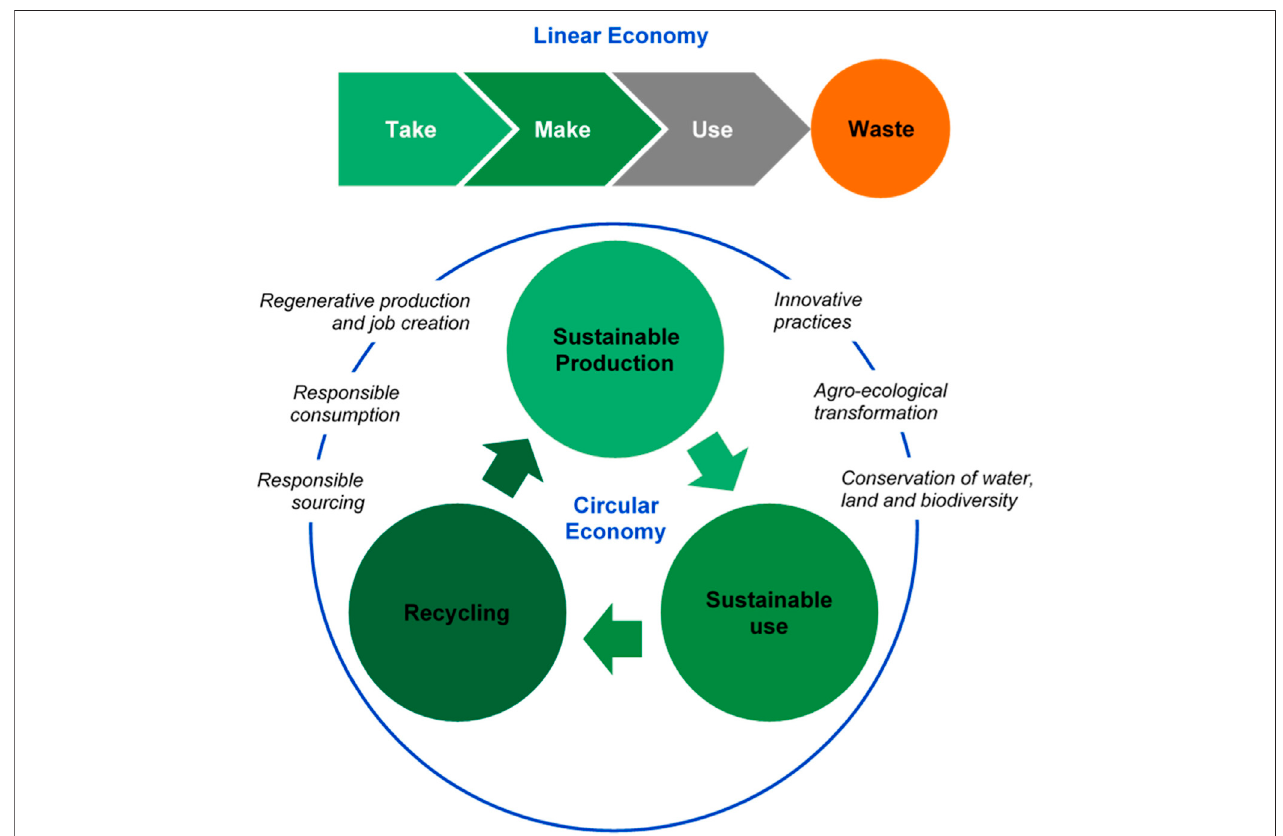
FIGURE 1 | Illustration of the concepts of linear and circular